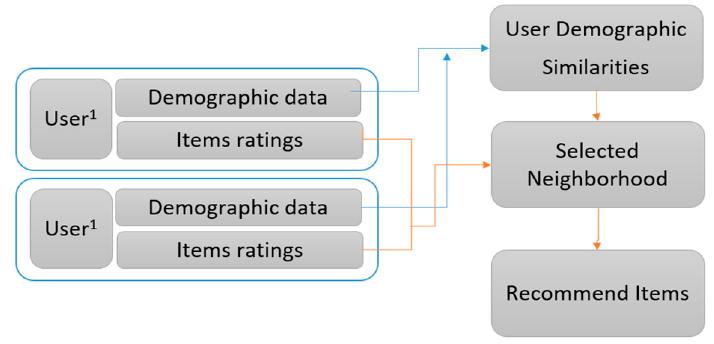
Figure 4. Demographic-based approach of any user.